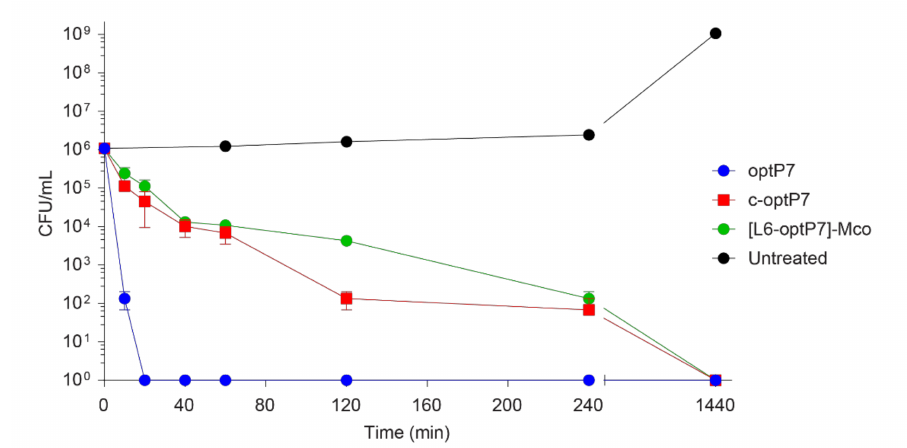
Figure 6. Time kill assay of three different peptides against E. coli , performed in 1/5 broth at 3 times the MIC. Curves represent the average of three experiments and the error bars show the standard deviation.